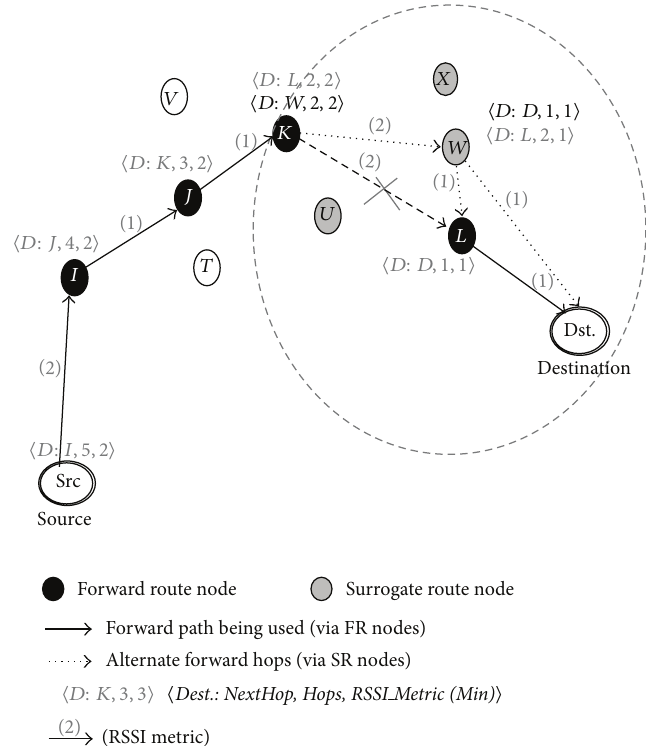
Figure 3: Illustration of the packet salvaging scheme.